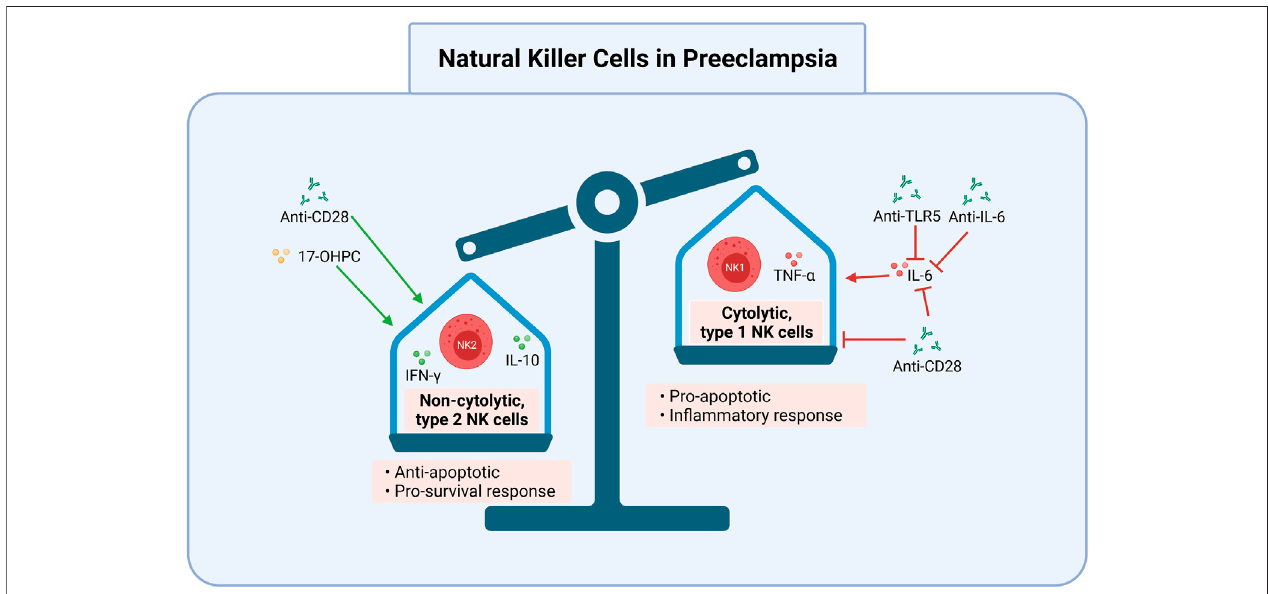
FIGURE3| Cytolytic NKcellsmaybetargeted inpreeclampsia. Induction ofnon-cytolyticNKcellsandinhibition ofcytolyticNKcellsisonepotentialavenueforthe treatmentand prevention ofpreeclampsia. Anti-TLR5,anti-IL-6,and anti-CD28inhibit IL-6 ’ s activation ofpro-apoptotic cytolytic type 1NK cells. Anti-CD28 also directly inhibits type 1 NK cells, and promotes non-cytolytic, type 2 NK cells and the anti-apoptotic cytokines IL-10 and IFN- γ . 17-OHPC works similarly to promote type 2 NK cells. Together, these reduce the cytolytic NK cell response, which can lead to improper placentation and subsequent preeclampsia. 17-OHPC, 17- hydroxyprogesterone caproate; anti, antibody; IFN- γ , interferon gamma; NK2, non-cytolytic, type 2 Natural Killer cells; IL, interleukin; NK1, cytolytic, type 1 Natural Killer cells; TNF- α , tumor necrosis factor alpha; TLR5, toll like receptor 5. Created with https://biorender.com.